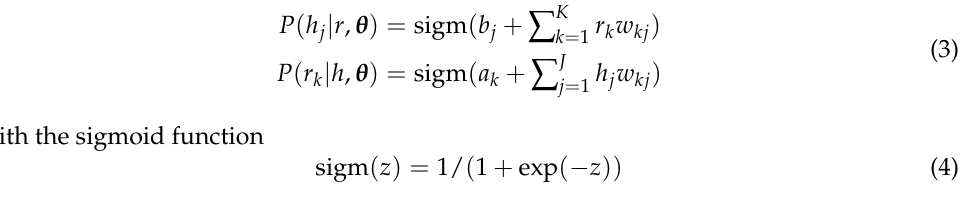
Figure 4. Schematic diagram for the RBM and training process for the pre-training. Given the state of the visible unit r and the state of the hidden unit h , the activation probabilities of h j and r k are written